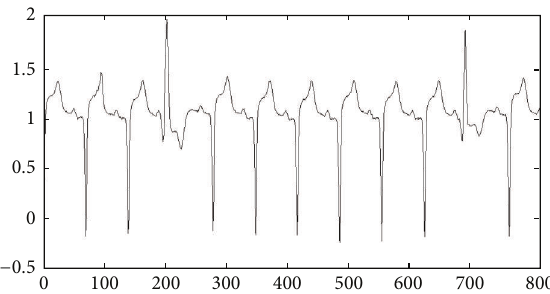
Figure 1: A sample of time series